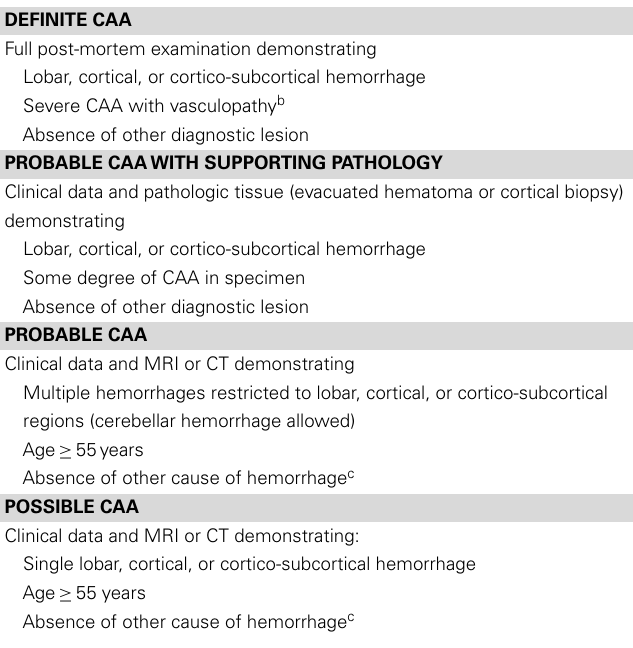
Table 1 | Boston criteria for cerebral amyloid angiopathy a